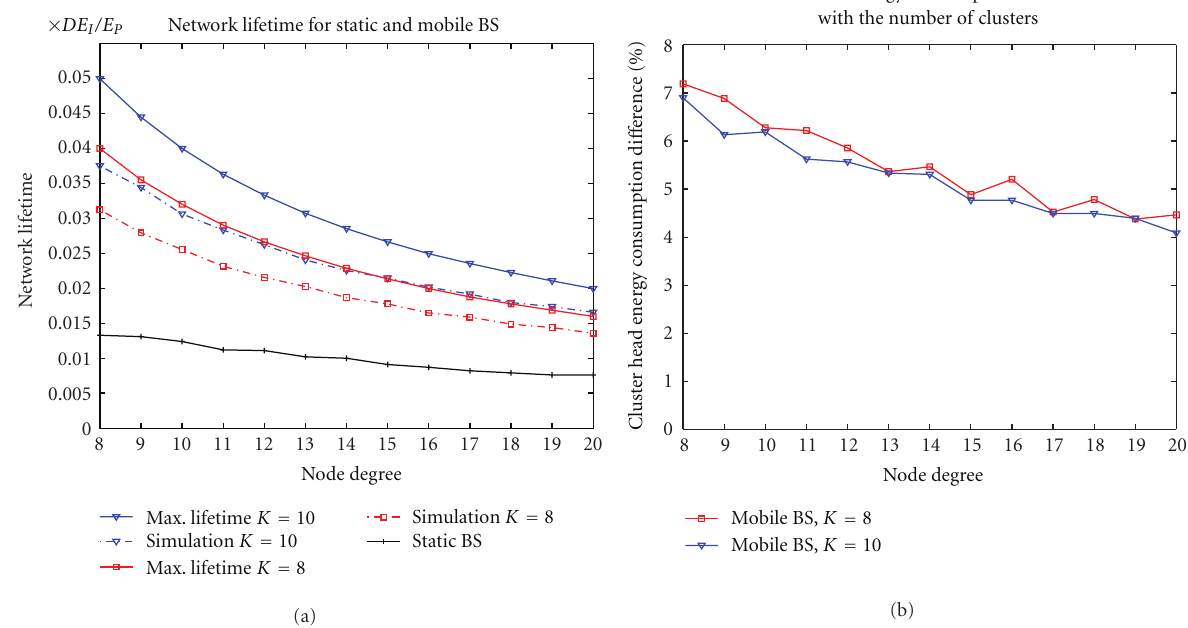
Figure 8: (a) Network lifetime as it varies with node degree, for static and mobile BSs with di ff erent K . The maximum network lifetime is calculated from (7), which assumes all clusters have the same number of nodes. (b) The minimum and maximum energy consumption di ff erences among the cluster heads as the node degree is